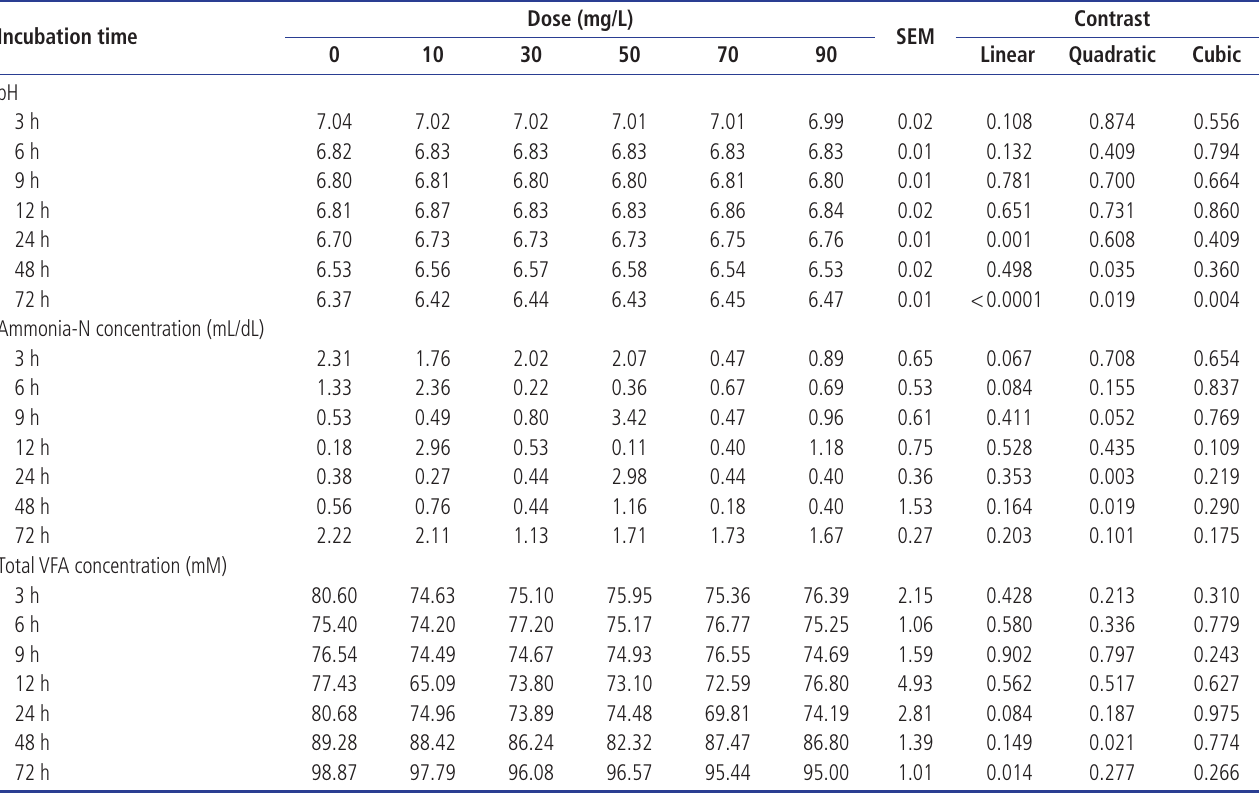
Table 3. Effects of different doses of Rhus succedanea extracts on in vitro pH, and ammonia-N and total volatile fatty acid concentrations by mixed rumen anaerobic microbial fermentation Incubation time